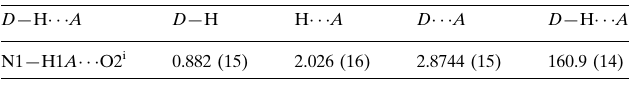
Hydrogen-bond geometry (A˚ , (cid:1)